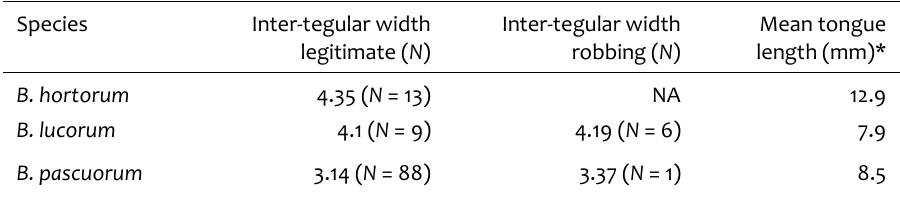
Table 1. Inter-tegular width of bumblebees observed legitimately visiting F. magellanica flowers, and robbing them. *Mean tongue lengths are taken from Goulson & Darvill